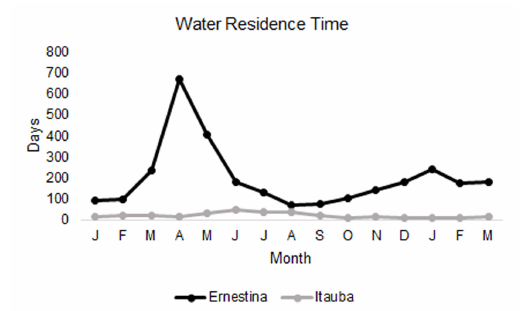
Figure 3. Average water retention time in in the Ernestina and Itaúba reservoirs between January 2012 and March 2013.